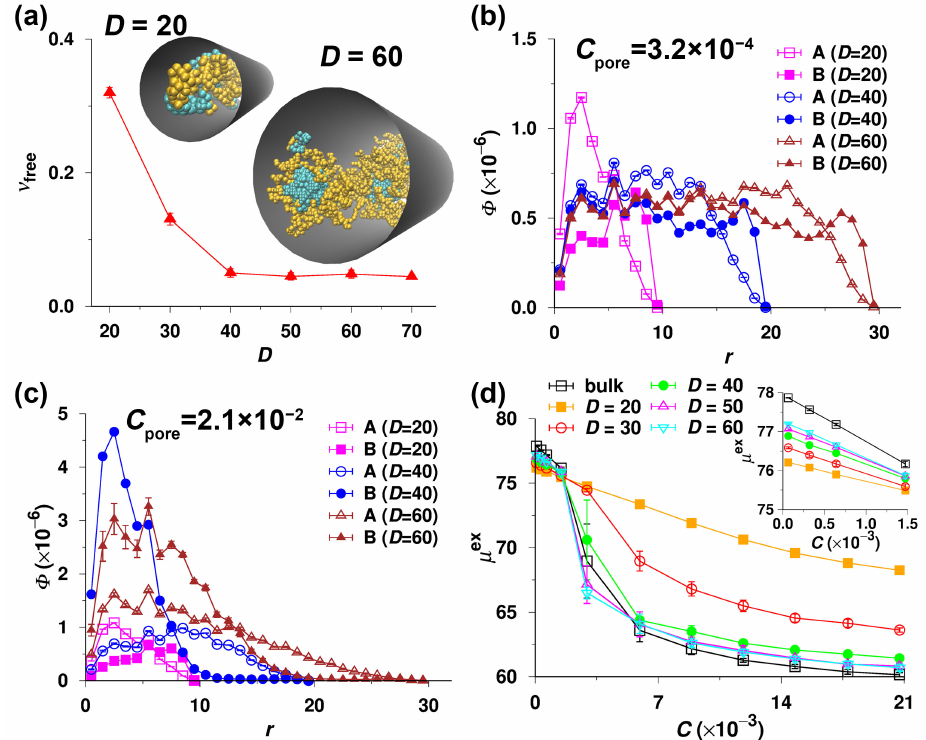
Figure 5. ( a ) The fraction of free chains, ν free , in the pore as a function of the pore diameter, D . The concentration C pore = 2.1 × 10 − 2 for all D . The typical snapshots of A32B32 diblock copolymers in a selective solvent confined in the pores of D = 20 and 60 are embedded, where the orange and cyan beads represent the solvophilic (A) and solvophobic (B) segments, respectively. ( b ) The concentration of beads, Φ , as a function of the distance to the pore center in the plane perpendicular to the pore axis, r , for C pore = 3.2 × 10 − 4 and various D . ( c ) Φ vs. r for C pore = 2.1 × 10 − 2 and various D . ( d ) Excess chemical potential, µ ex , as a function of concentration, C , for the A32B32 diblock copolymers in the bulk and in the pores of various D . The zoomed-in view of µ ex vs. C at C ≤ 1.5 × 10 − 3 is shown in the inset. Note that all the data shown in panels a to d were obtained from the simulations which were individually performed in the bulk and in the